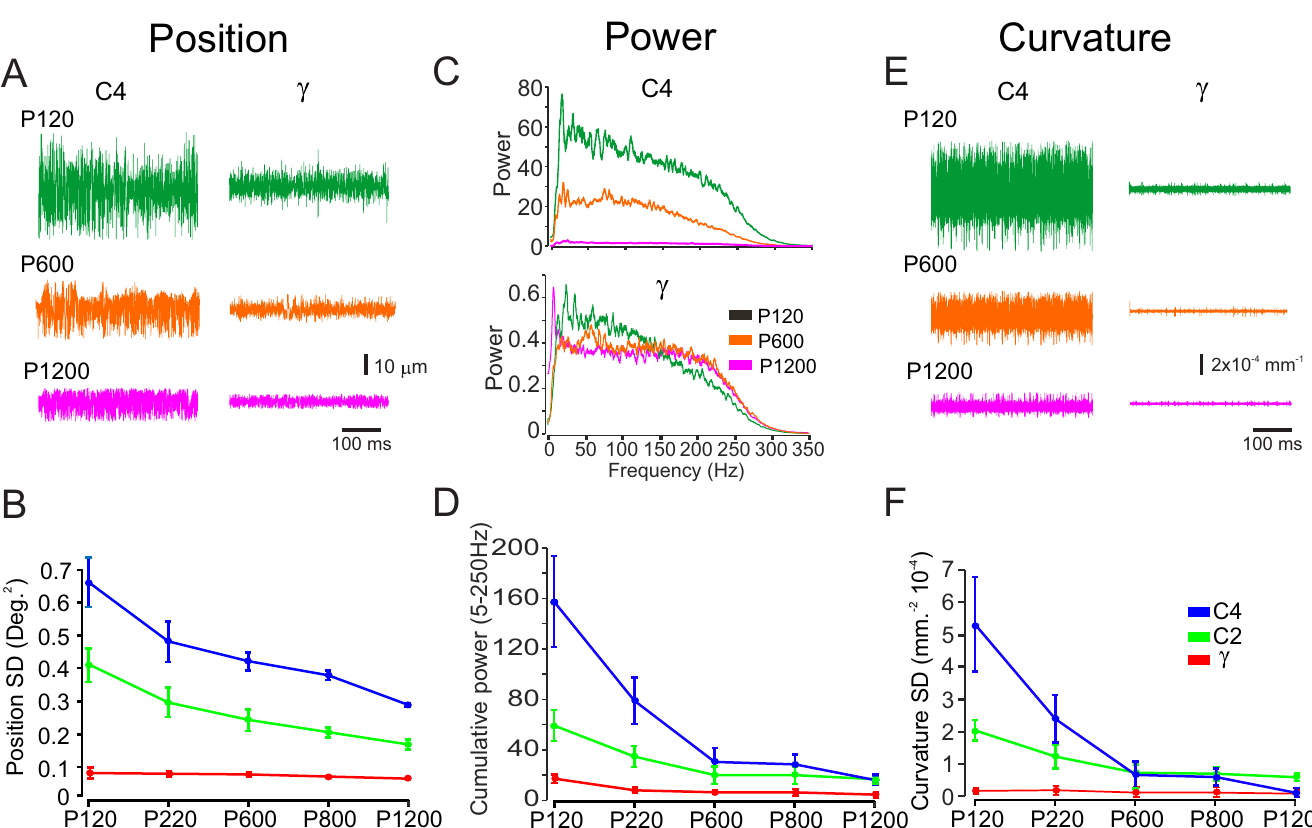
Fig 2. Rostral whiskers exhibit higher responses range to different texture grain. (A). Example of 2 outermost whiskers’ (C4, γ ) vibrations in response to textures (P120, P600, P1200). (B) The panel shows the quantification of 3 whiskers’ vibrations’ SD in response to different textures. (C) Power spectra of movements of the same whiskers across different textures is shown color coded. (D) The panel shows the quantification of 3 whiskers’ vibrations’ cumulative power in the 5–250 Hz range in response to different textures. (D) The intrinsic curvature of 2 outermost whiskers in response to the same textures as in A. (E) The panel shows the quantification of 3 whiskers’ curvature SD in response to different textures. These examples show a higher sensitivity to the different textures in rostral whiskers in all of these parameters. The underlying data for this Figure can be found in S1